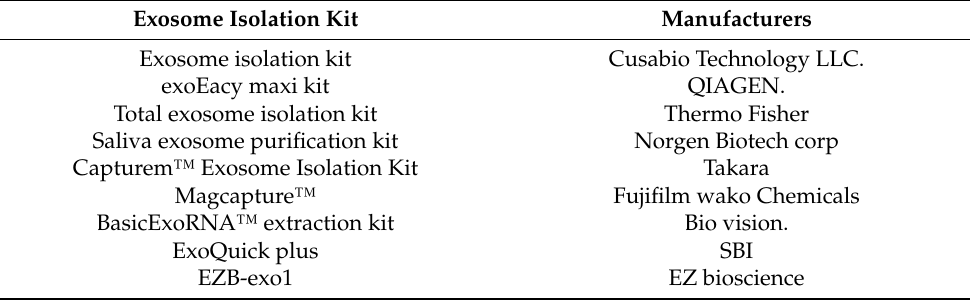
Table 2. Commercially available exosome isolation kits based on the principle of